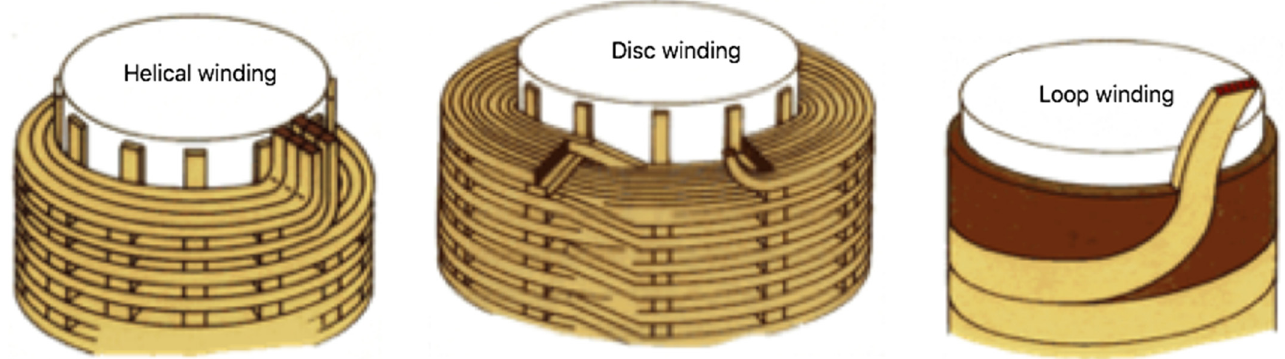
Figure 3. Step-up transformer winding design.